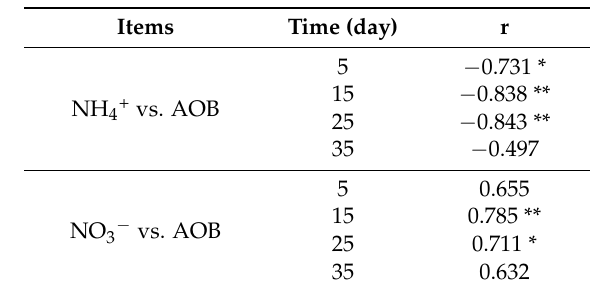
Table 3. Correlation analyses NH 4+ vs. AOB and NO 3 − vs. AOB profiles in pore water of the Chironomid larvae treatment ( p = 0.05). Items Time (day) r